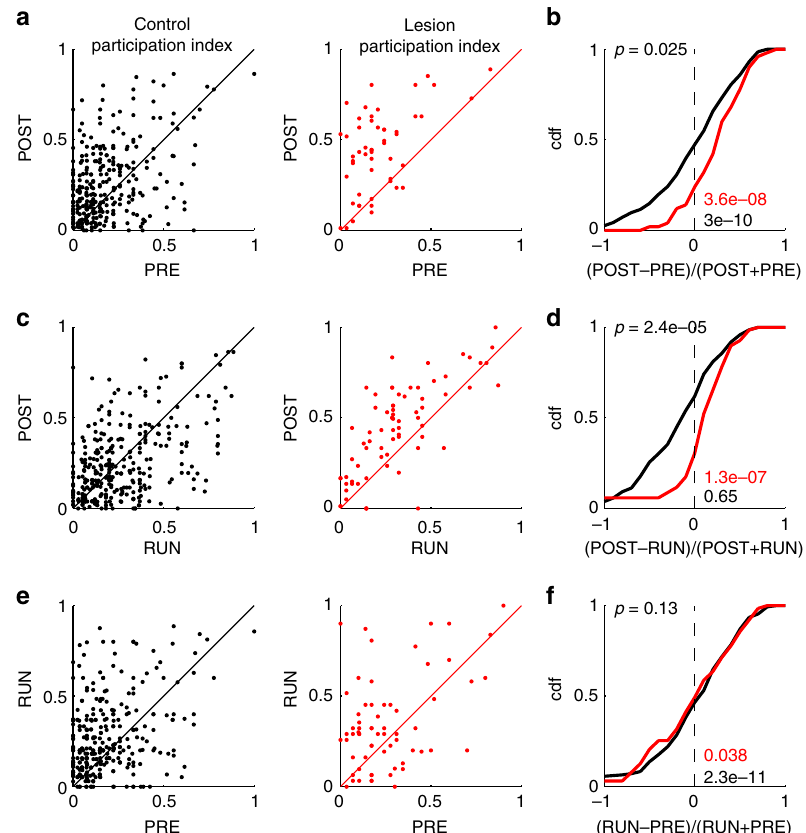
Fig. 4 Place cell participation in spatial sequences. a , c , e Correlation of cell-wise participation in signi fi cant spatial sequences between two epochs. Each dot indicates the participation of a place cell in signi fi cant spatial sequences in the two epochs indicated on the axes (POST vs. PRE: a , b POST vs. RUN: c , d ; RUN vs. PRE: e , f ). Left: control animals (black); right MEC-lesioned animals (red). b , d , f CDFs of the relative changes (as indicated at the x -axis) from the data in ( a , c , e ). The p values at the bottom right were derived from signed-rank tests of medians larger than 0 (PRE – POST Control: s.r. = 33274, n = 312 place cells; PRE – POST MEC-lesioned: s.r. = 1281, n = 52 place cells; RUN – POST Control: s.r. = 23794, n = 314 place cells; RUN – POST MEC-lesioned: s.r. = 2290, n = 73 place cells; PRE – RUN Control: s.r. = 34498, n = 310 place cells; PRE – RUN MEC-lesioned: s.r. = 1344.5, n = 65 place cells). The p value on the top left was obtained by a ranksum test on identical group medians (PRE – POST: r.s. = 55,364, n control = 312 place cells, n lesion = 52 place cells, RUN – POST: r.s. = 57,277, n control = 314 place cells, n lesion = 73 place cells; PRE – RUN: r.s. = 59,490, n control = 310 place cells, n lesion = 65 place